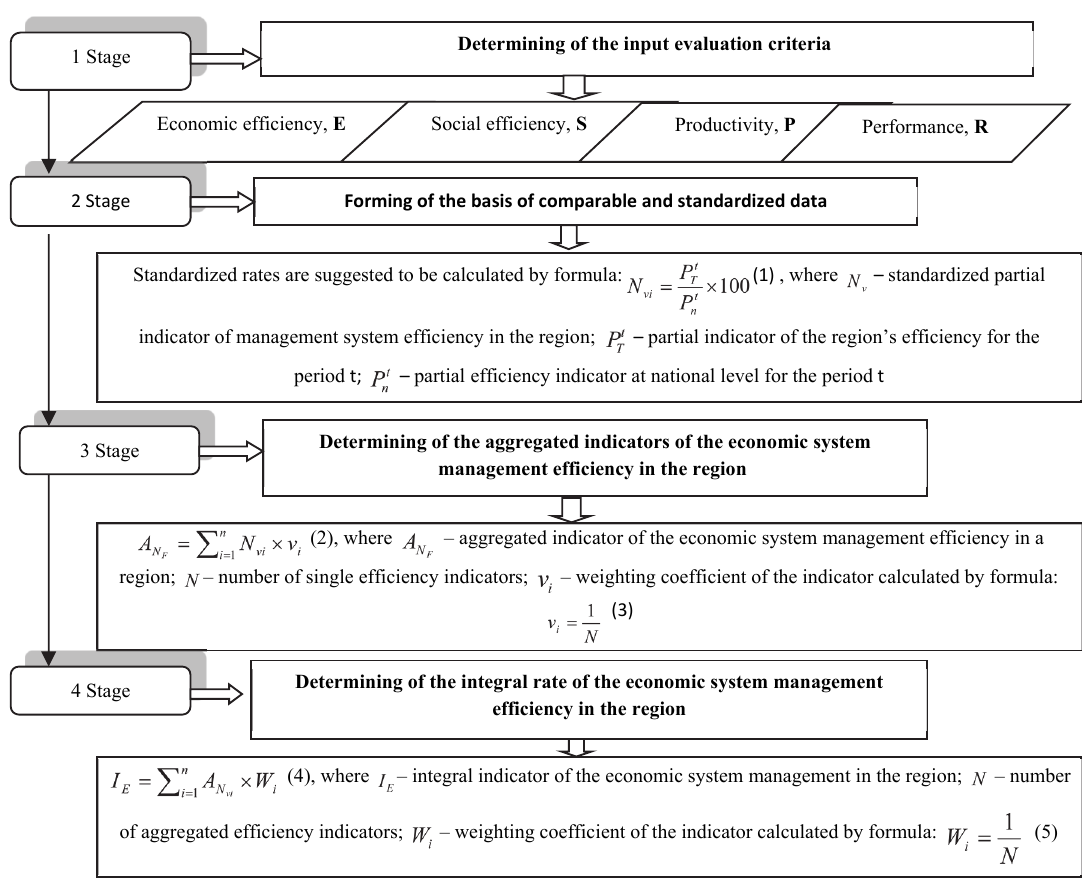
Fig. 1. Stages of evaluation of the economic system management efficiency in the region Source: developed by